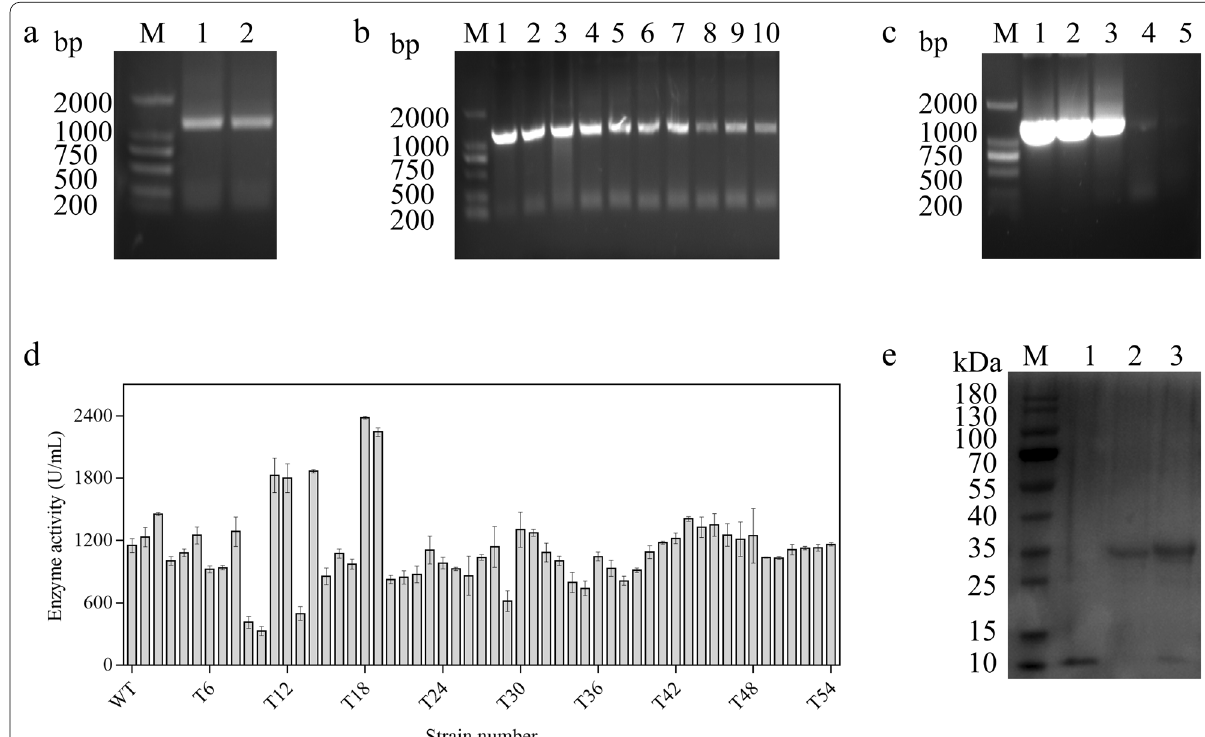
Fig. 1 Screening of recombinant strains. a Verification of gene kerBp . Lane M, DNA marker; Lane 1–2, PCR amplification of kerBp . b Mg 2 + concentration gradient. Lane M, DNA marker; lane 1–10, Mg 2 + : 1 mM, 2 Mm, 3 mM, 4 mM, 5 mM, 6 mM, 7 mM, 8 mM, 9 mM, 10 mM. c Mn 2 + concentration gradient. Lane M, DNA marker; lane 1–5, Mn 2 + : 0.1 mM, 0.2 Mm, 0.3 mM, 0.4 mM, 0.5 mM. d Rescreening results of shake flasks. e SDS‑PAGE analysis of WT and variant T18. Lane M, protein MW markers; lane 1, supernatant of fermentation broth from B. subtilis WB600 harboring pMA5 as the control; lane 2, WT; lane 3, variant